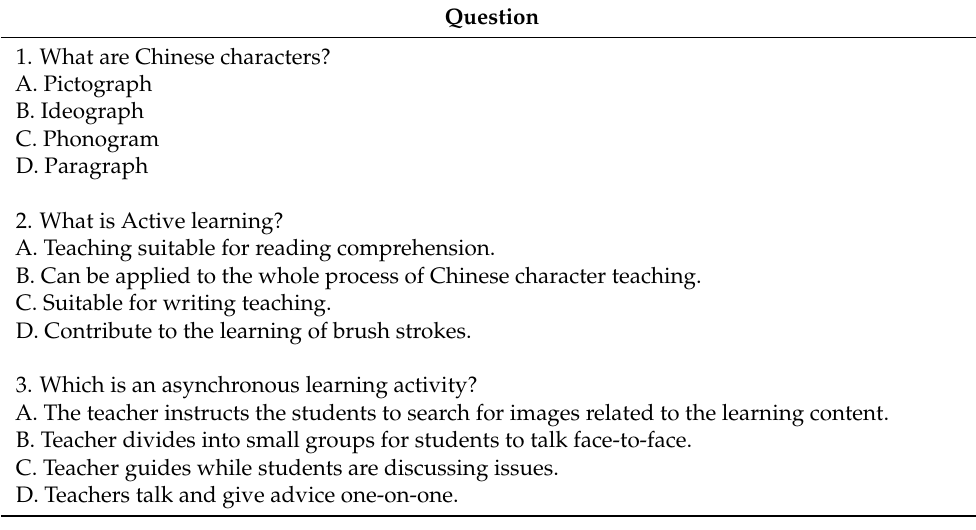
Table 1. Sample pre- and post-test